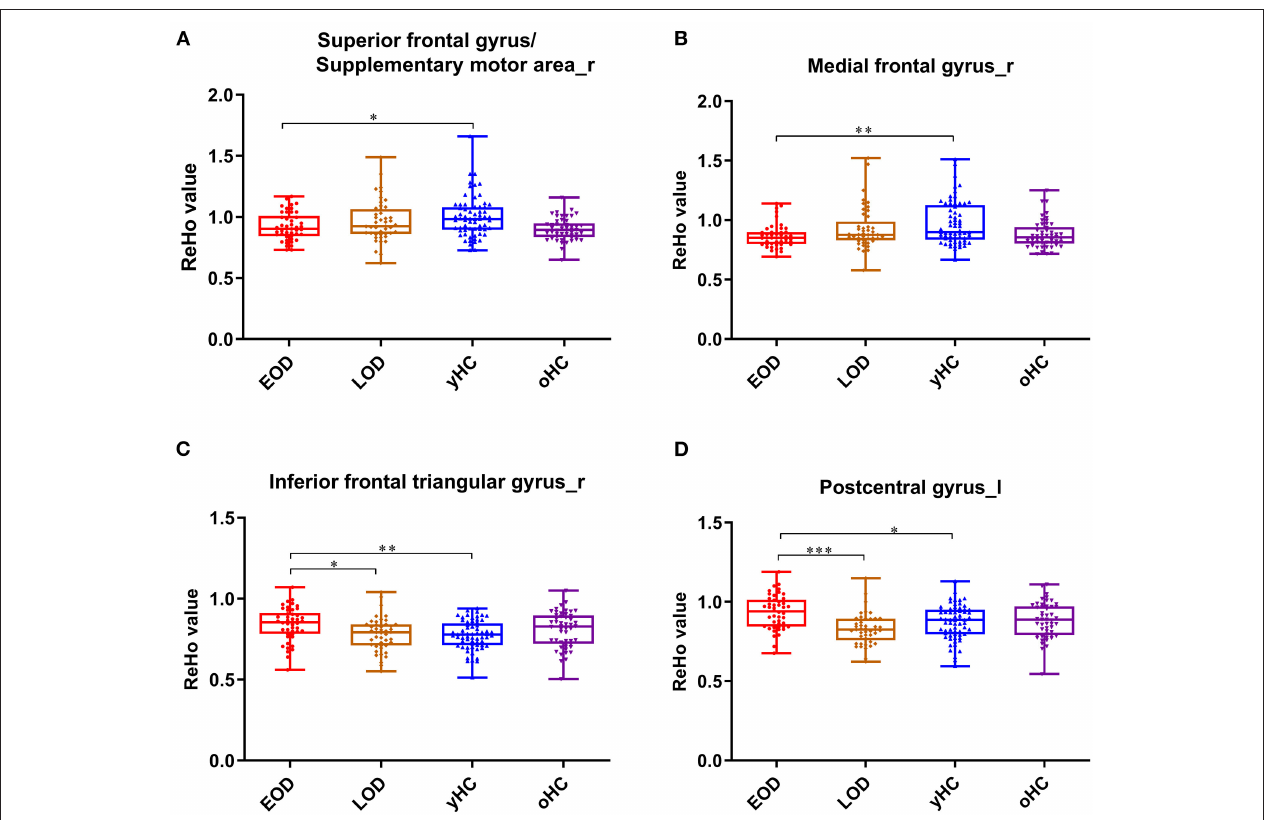
FIGURE 2 | The box plots for the comparison between EOD, LOD patients, and young and old HCs. In the right superior frontal gyrus (supplementary motor area) (A) , right medial frontal gyrus (B) , right inferior frontal triangular gyrus (C) , and lest postcentral gyrus (D) . * p < 0.05, ** p < 0.01, *** p < 0.001.